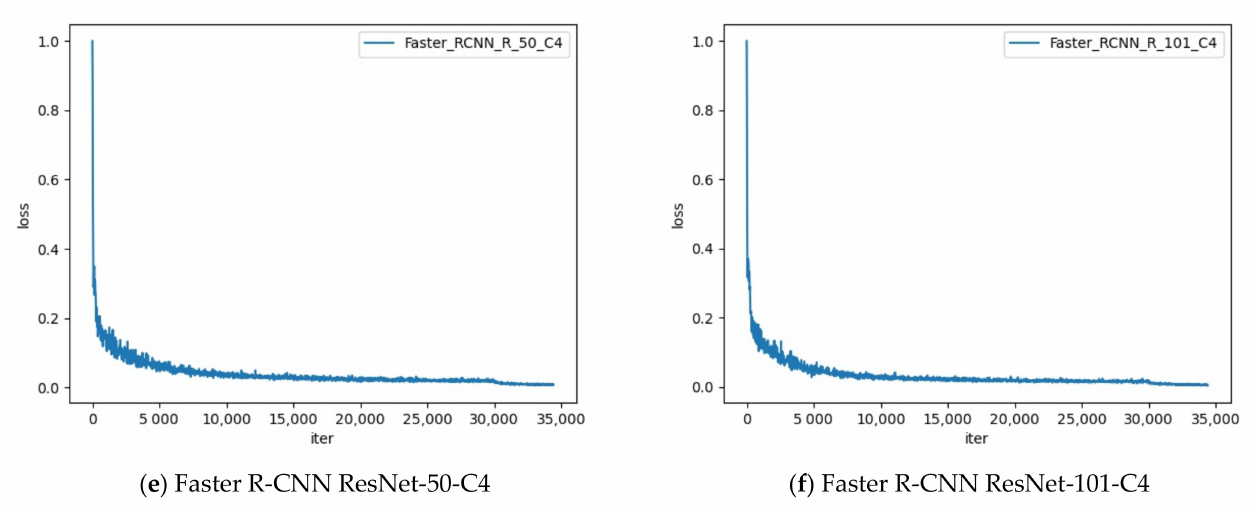
Figure 12. Training loss for two-stage method models.